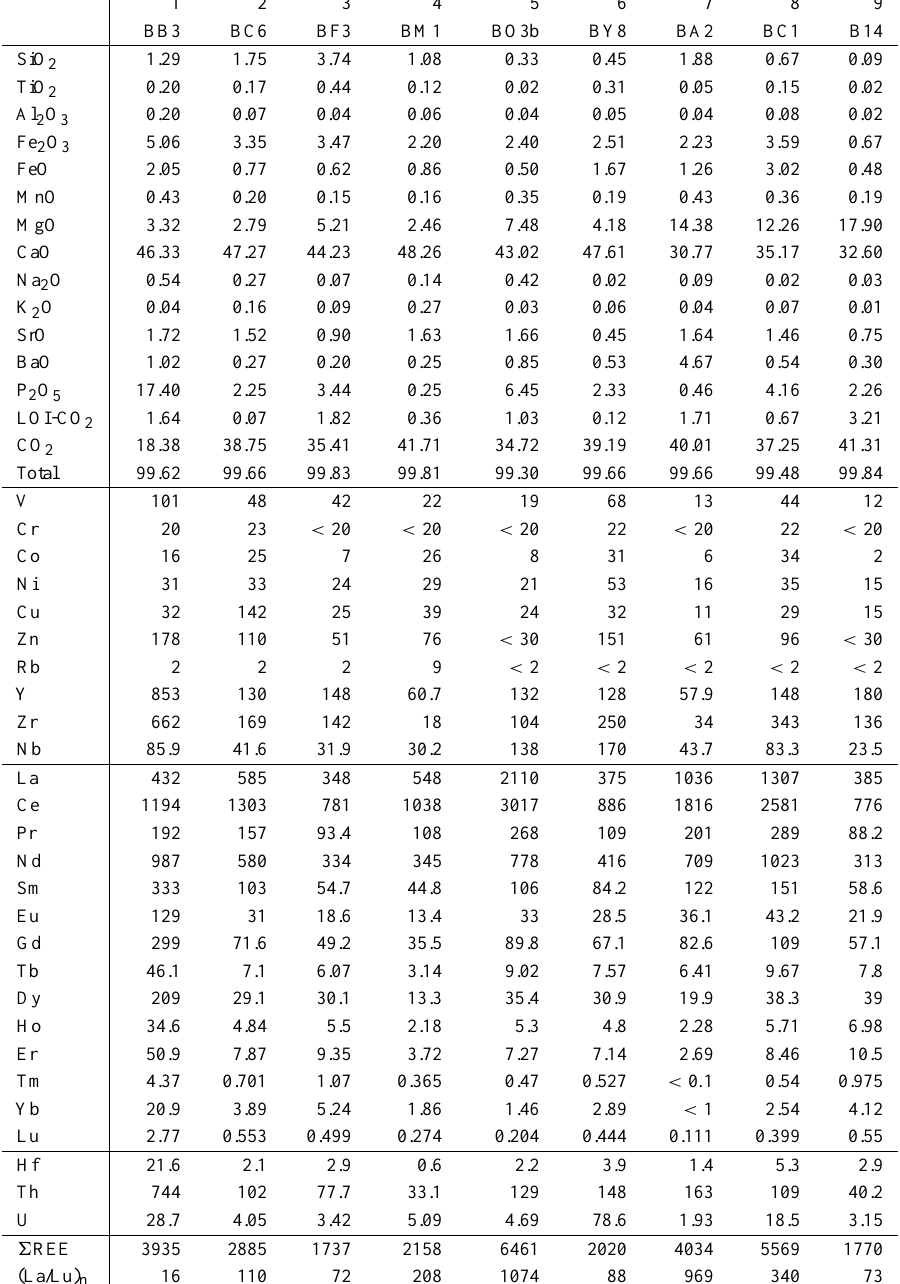
Representative bulk-chemical analyses of Araxá carbonatites (1, CaCPh; 2-6, CaC; 7-12, MgC; 13, FeC; 14, FeCPh; 15-17, FeC). For rock abbreviations see Table I; Ph, phoscorites. Major and trace elements in wt% and ppm,